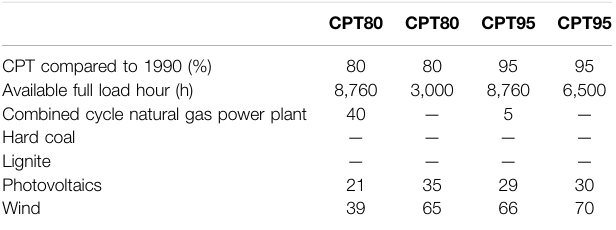
TABLE 5 | Electricity supply mixes assumed for 2050 based on data from TUM (Bareiß et al., 2018; Bareiß et al.,